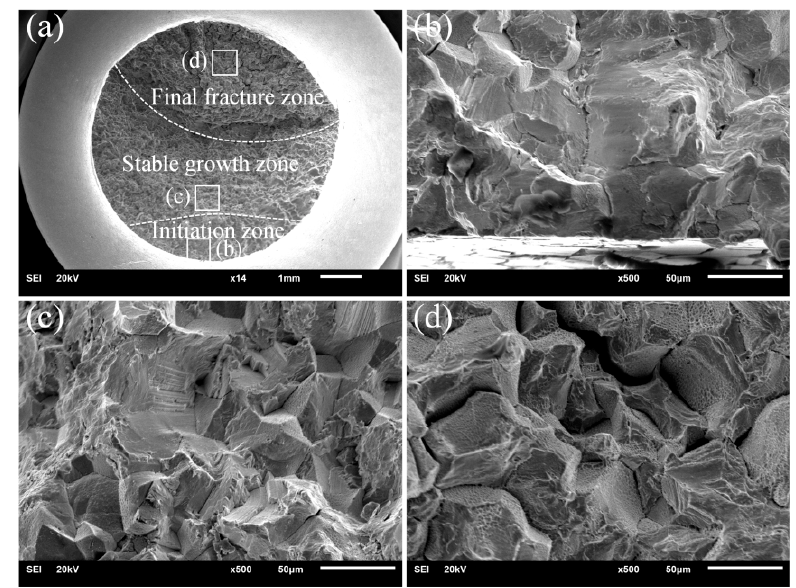
Figure 8. Fracture observations of an overload specimen: ( a ) Overview of the fracture; ( b ) Crack initiation zone; ( c ) Crack stable growth zone; ( d ) Final fracture zone.